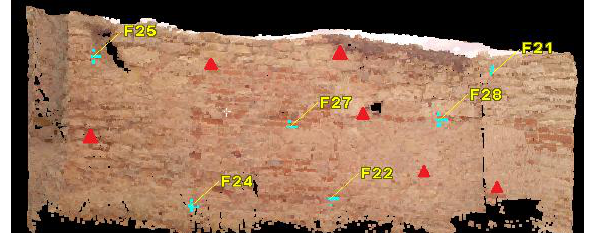
Figure 5. Example of textured point cloud with the reference points